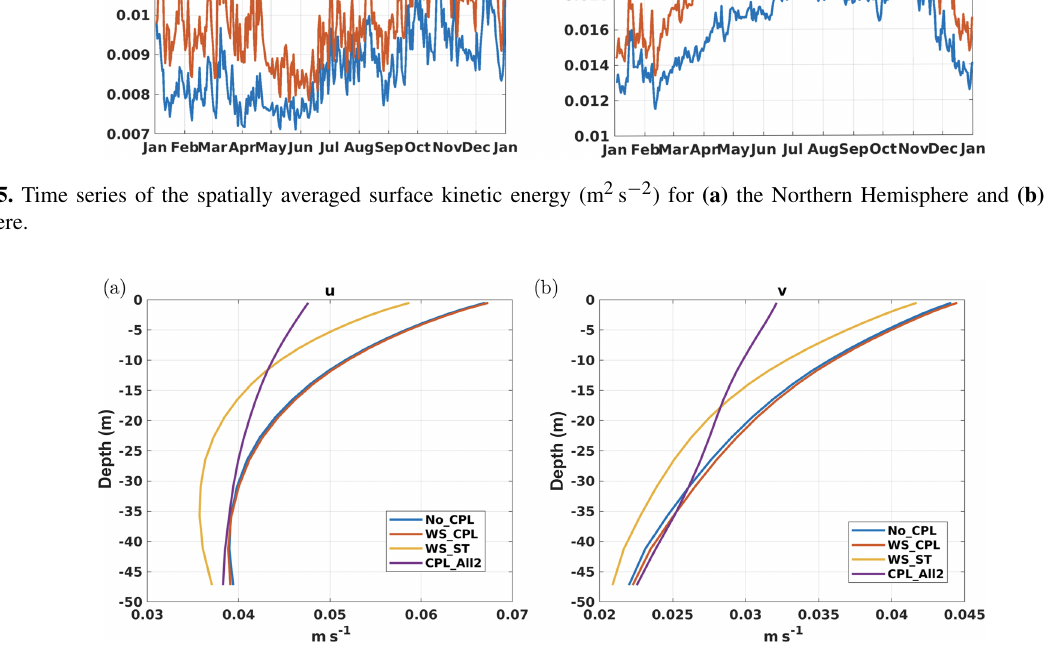
Figure 16. Zonally averaged zonal (a) and meridional (b) currents (ms − 1 ) between 60 and 25 ◦ S as a function of depth (m) for the simulations described in Table